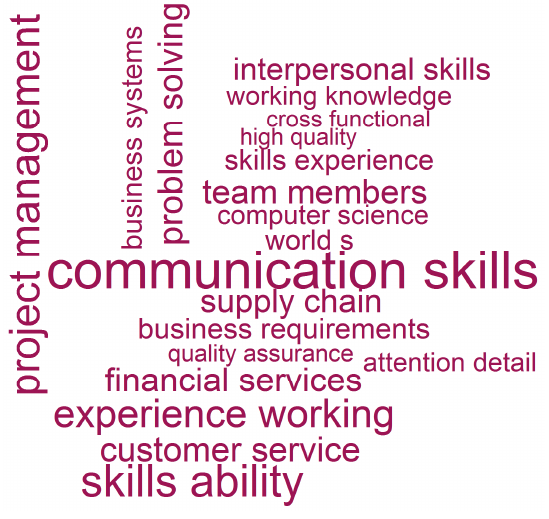
Figure 14. Job Descriptions Visualization—Analyst (unseen